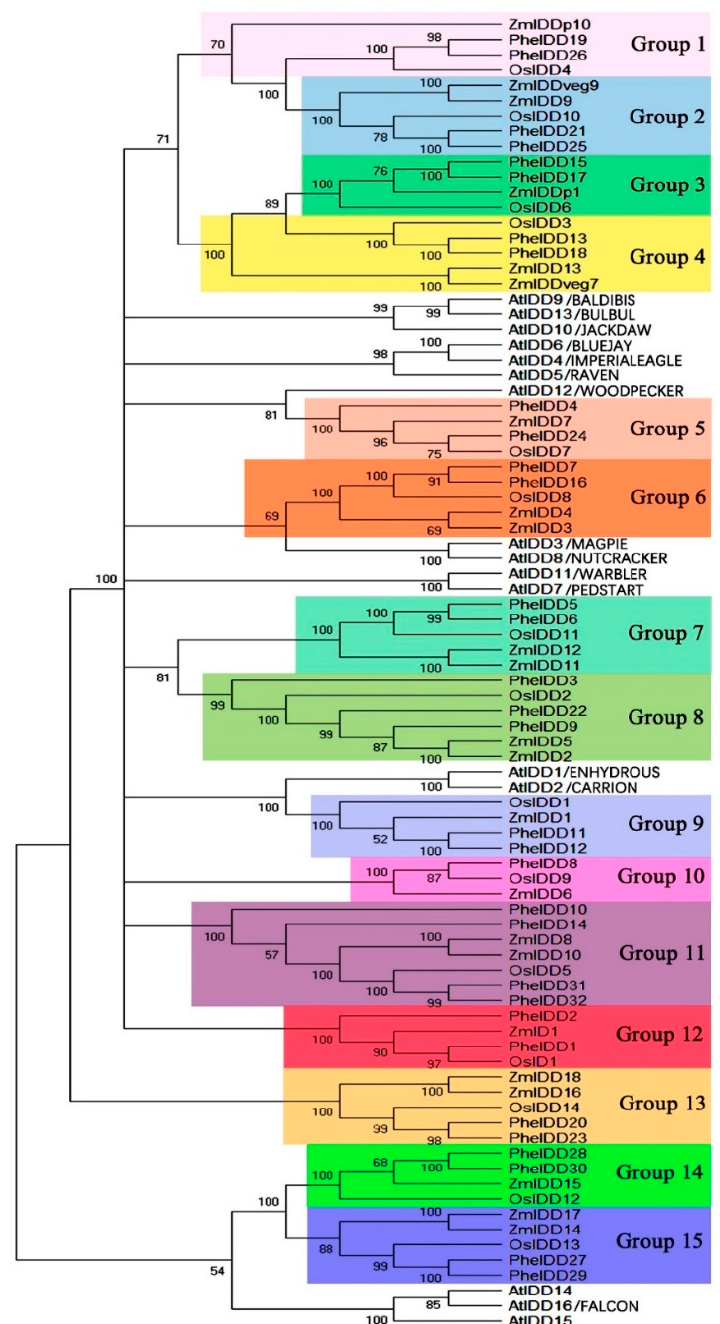
Figure 3. Phylogenetic analysis of IDD homologs from four different plant species: Arabidopsis thaliana , Z. mays , O. sativa , and Ph. edulis . The tree was constructed by the neighbor-joining method using MEGA6.0 software with default parameters. Bootstrapping was performed 1000 times, and percentage support values are shown on branches. Putative orthologous groups are highlighted with colored boxes. The accession numbers of the genes used for sequence analysis and tree construction are shown in Table